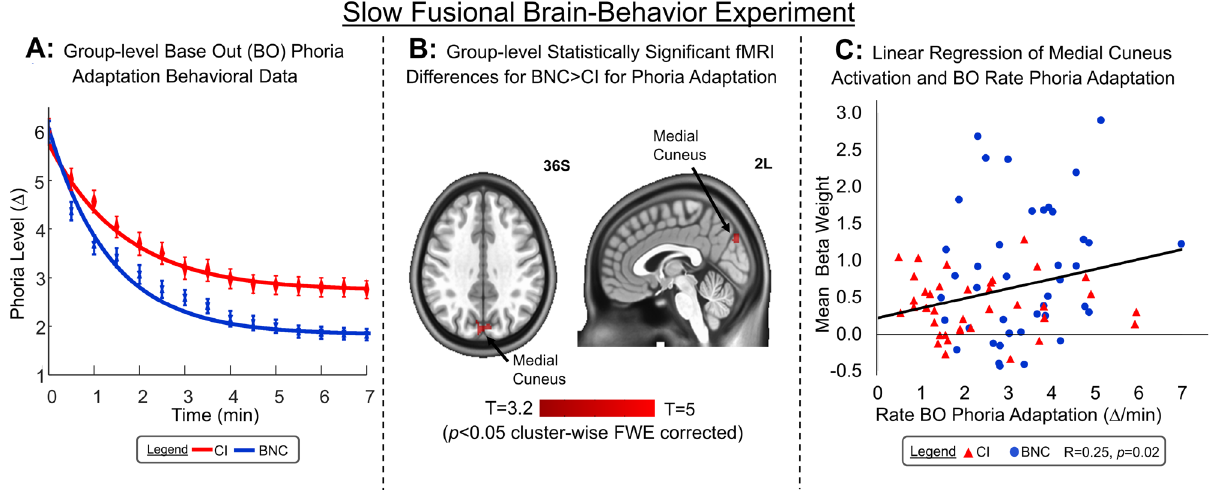
Figure 2. ( A ) Group-level averaged phoria adaptation results of phoria (∆) as a function of time (min) using a 6∆ base-out (BO) prism for BNC (blue symbols) and CI (red symbols) groups ± 1 standard error of the mean. Exponential decay fit of BNC group (solid blue line) and CI group (solid red line). ( B ) Two-sample unpaired t-test of functional activity differences between BNC and CI groups during the phoria adaptation slow fusional experiment showing medial cuneus was significantly different between groups. ( C ) Linear regression of mean beta weight from medial cuneus ROI using a 5 mm radius sphere as a function of the rate of phoria adaptation (∆/min) to 6∆ BO prism for BNC (blue circle) and CI (red triangle) participants. Linear regression (solid black line) analysis shows the Pearson’s correlation coefficient of r = 0.25, p < 0.02 between medial cuneus functional activity and rate of phoria